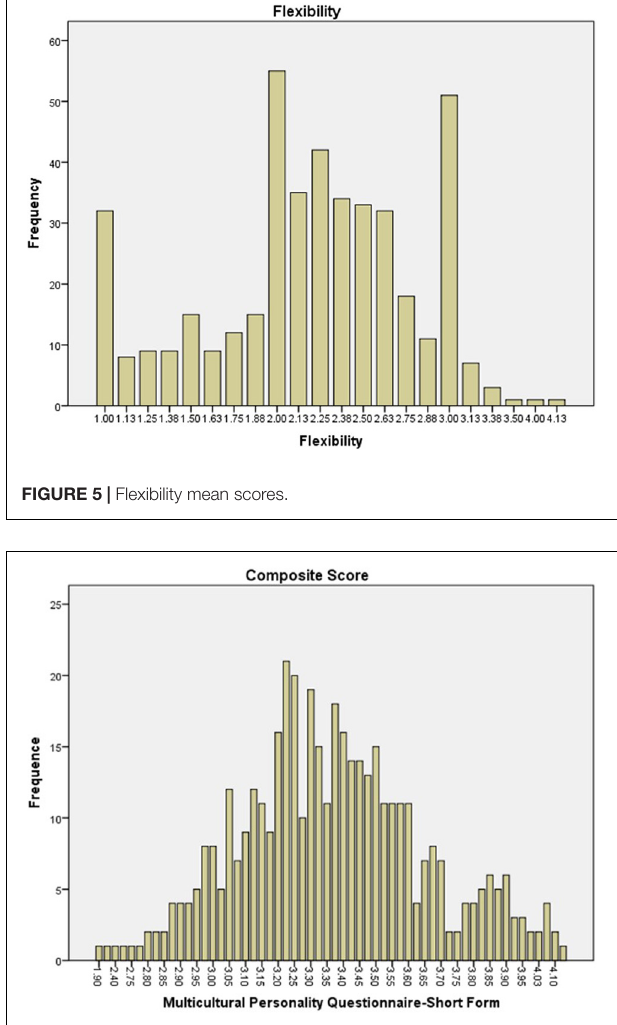
FIGURE 4 | Social Initiative mean scores.